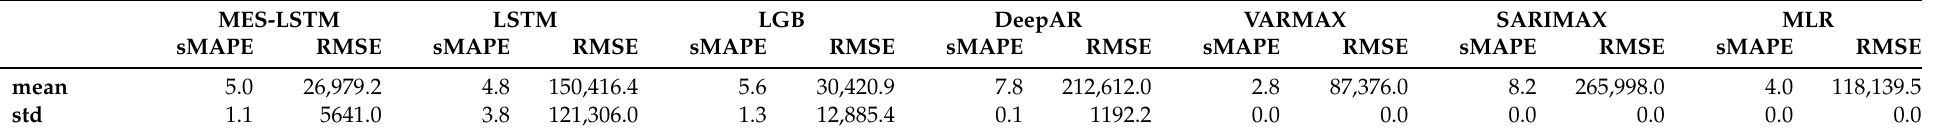
Table 8. Forecast Accuracy Distribution for All Trials for total cases in South Africa.